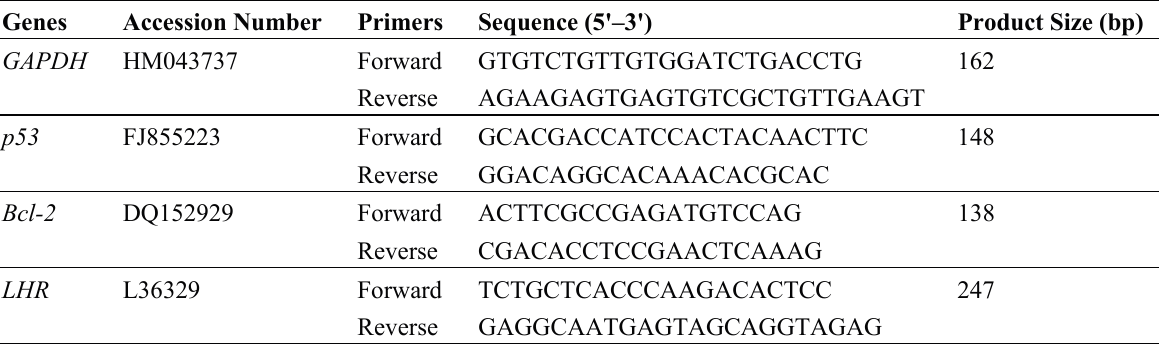
Table 1. Primers used in this